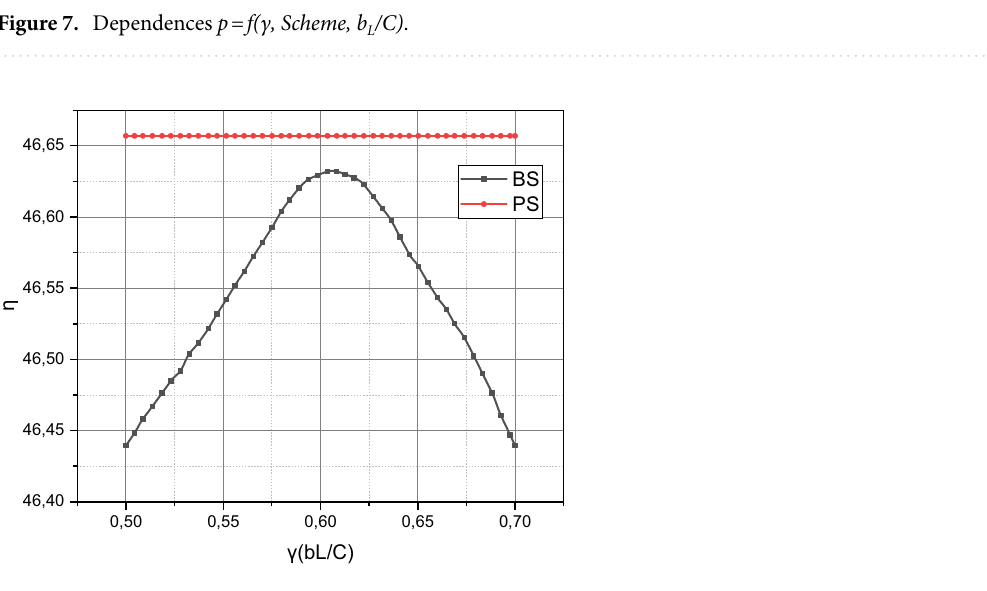
Figure 8. Dependences η = f(γ, Scheme, b L /C)